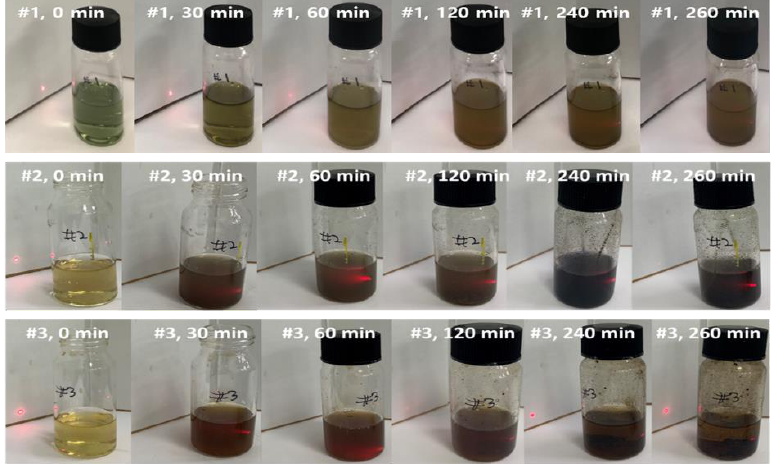
Figure 3. Visual observation of GA/ATS/alkaline buffer solutions with incubation time (#1): APTES; ( #2 ): TMPEDA; ( #3 ): TMPDETA.